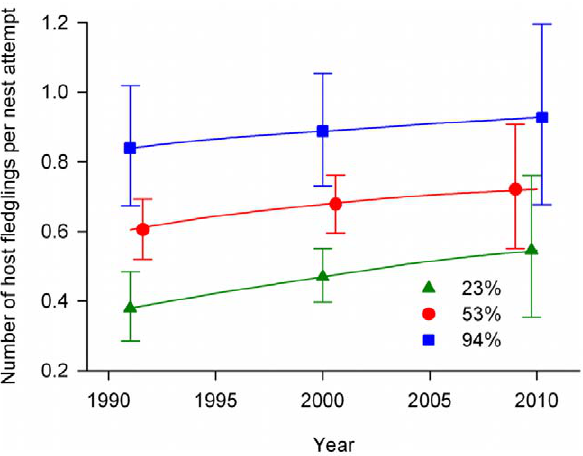
Figure 6. Productivity per nest attempt. Average productivity per nest attempt across time at 5%, median, and 95% observed values of forest cover (23%, 53%, and 94%, respectively) for a balanced population of three songbird species in a study of brood parasitism and nest predation in Missouri, USA, 1991–2010. Error bars represent 95% confidence intervals and are offset for visual